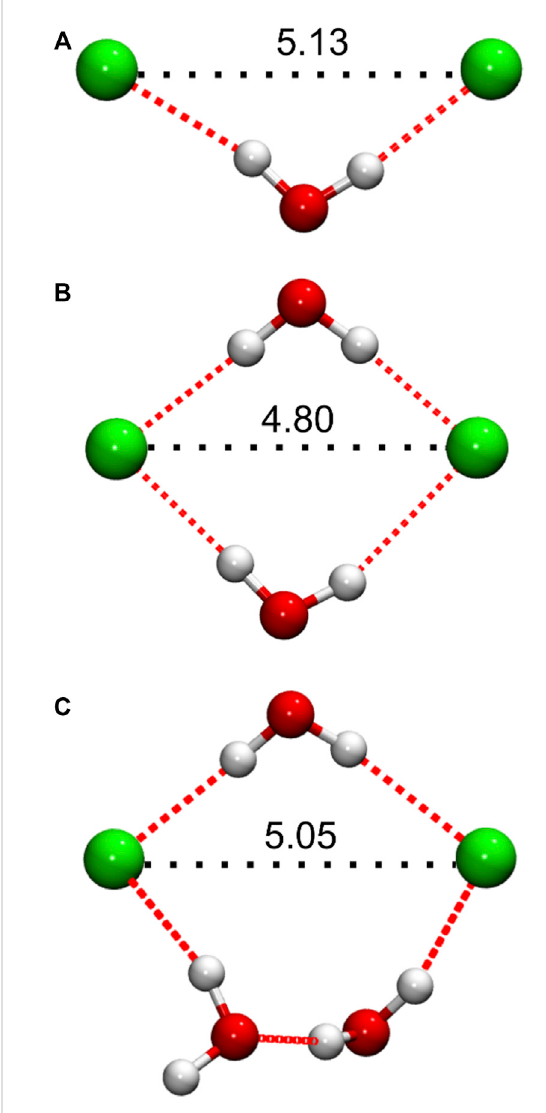
FIGURE 6 Representative Cl − anion pair con fi gurations from simulated DES/water systems, showing water molecules involved in the formation of H-bonded (dotted red lines) bridging structures, as discussed in the main text. Distances (Å) between the Cl − anions are indicated in black, as relevant to the interpretation of the corresponding g ClCl ( r ) functions. (A) Single, and (B,C) double H-bonded bridging arrangements. Con fi gurations (A,B) were taken from the DES/water mixture with x W = 0.125, while (C) was taken from x W = 0.5.